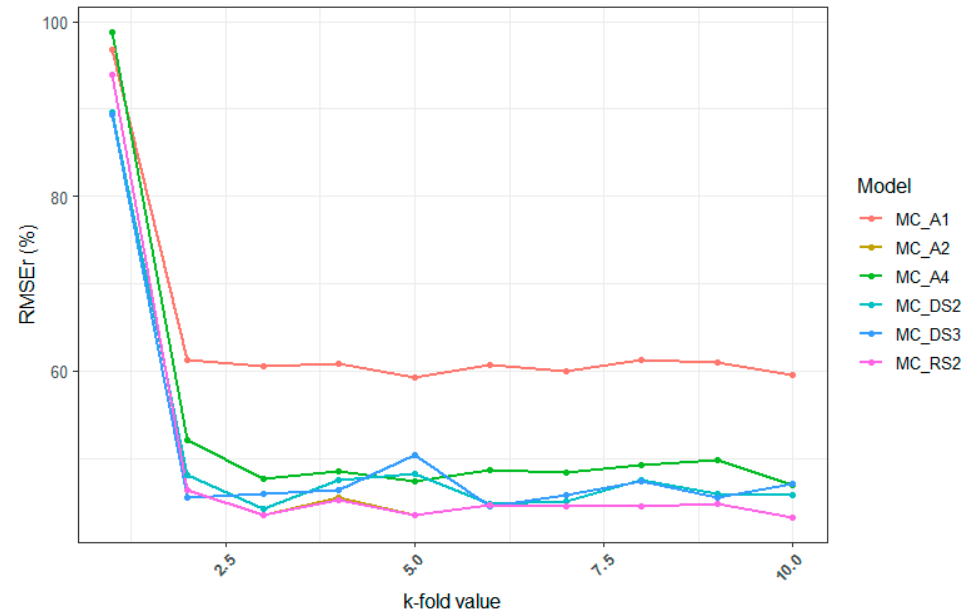
Figure 5. Sensitivity of the RMSEr values to different k-fold values for the MC based models.